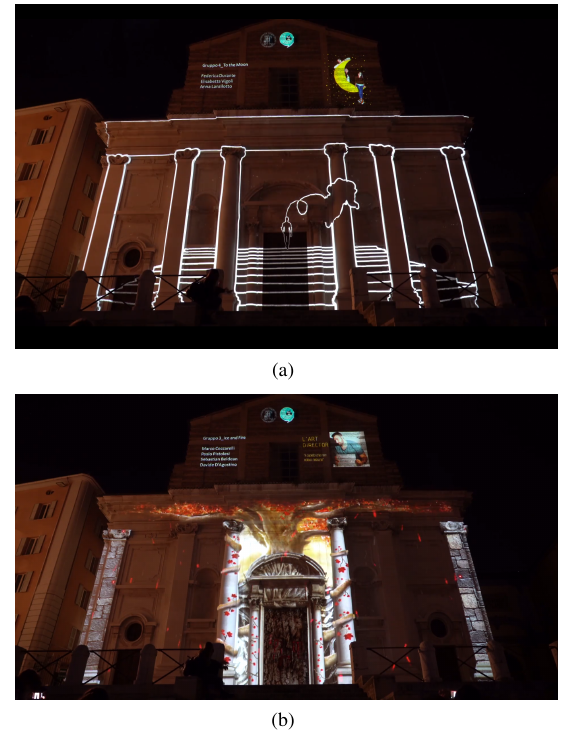
Figure 6. Two examples of different approaches: To the moon (a), Ice and fire (b) Sharper